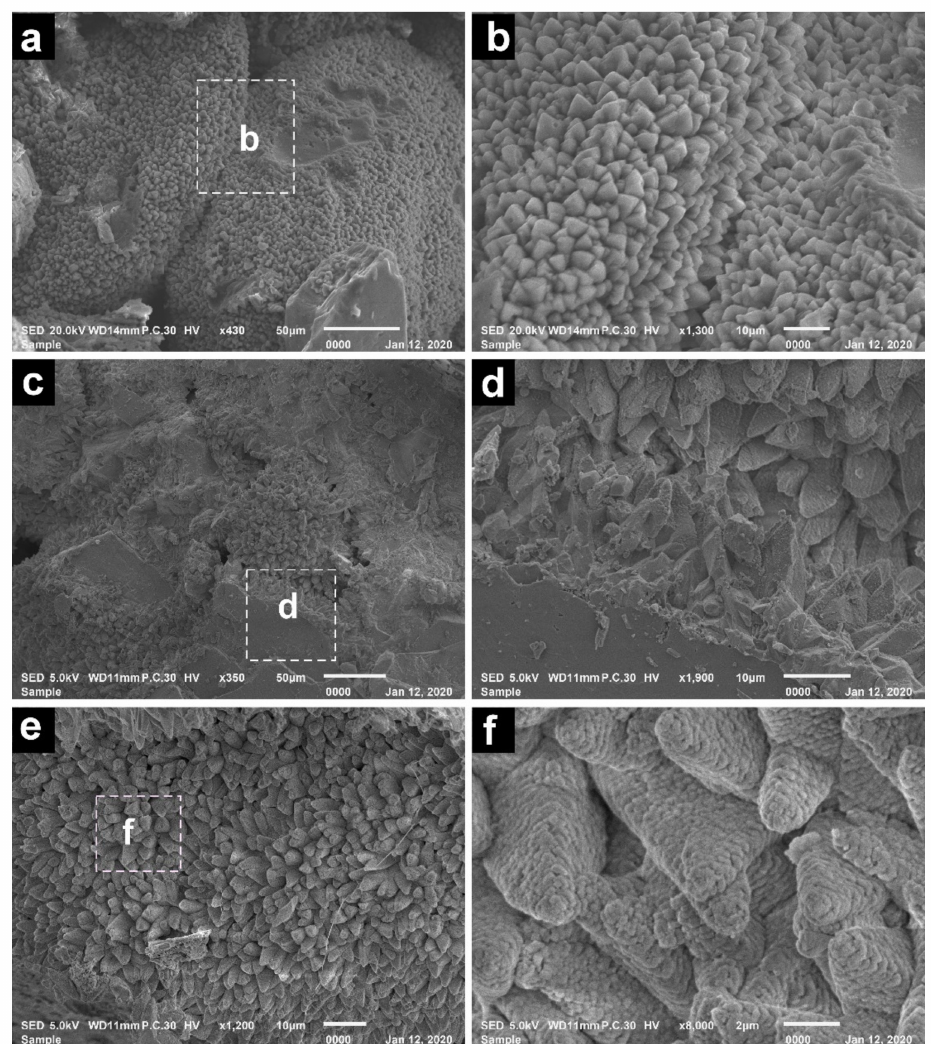
Figure 5. SEM photomicrographs showing the characteristic features of the HMC cement in the beachrock of Al-Mejarma: ( a , b ) Isopachous rim with scalenohedral HMC crystals; ( c – f ) HMC cement with bladed morphology, with crystal showing dissolution features of rounded corroded crystal outlines in HMD7 ( e , f